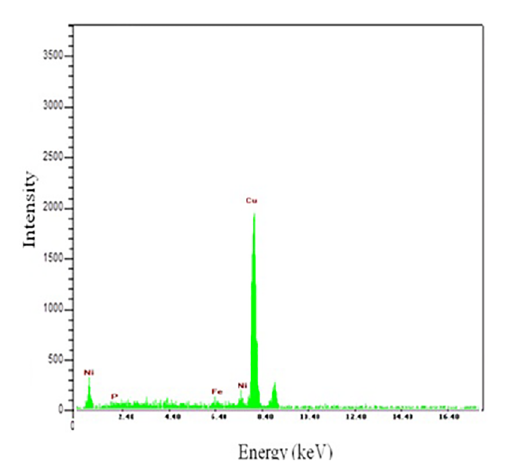
Figure 3. EDS analysis of Ni-P-Cu composite coatings, a) 1gr/lit Cu, b) 3 gr/lit Cu, c) 5 gr/lit Cu, d) 7 gr/lit Cu.